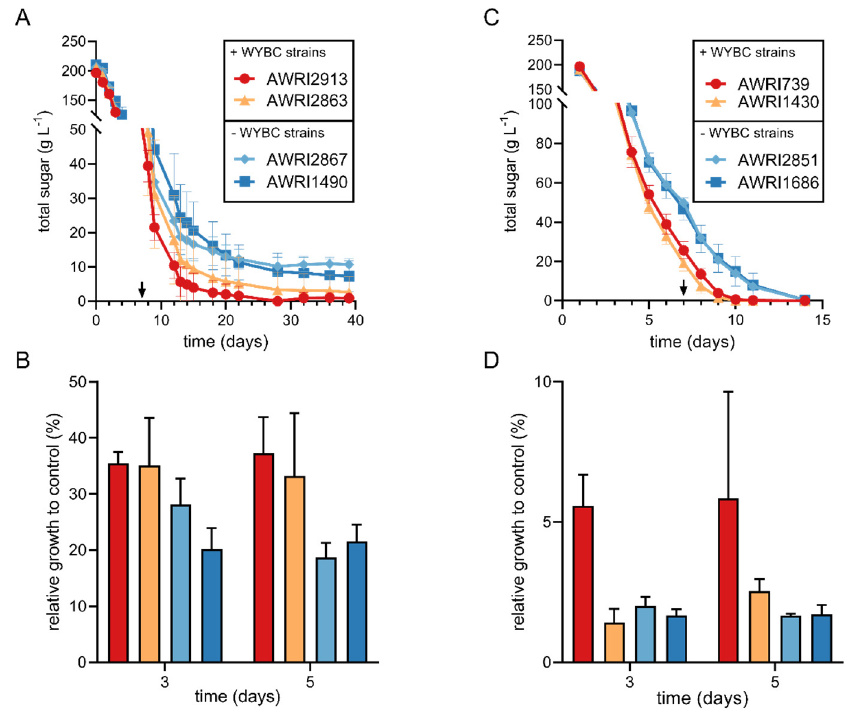
Figure 2. Fermentation kinetics and relative growth in CDM of Saccharomyces cerevisiae strains in the presence of Metschnikowia pulcherrima ( A , B ) and Torulaspora delbrueckii ( C , D ). + and - WBYC strains refer to strains that showed a positive or negative log 2 FC in the WYBC library competitive fitness experiments for the specific non- Saccharomyces treatment (Figure 1). The arrows in panels ( A , C ) indicate the time point when all S. cerevisiae controls finished fermentation. The relative growth in panels ( B , D ) are expressed as a percentage of cells in the specified timepoint relative to control conditions without the presence of a non- Saccharomyces species. All data points correspond to the mean of three replicates ± sd.